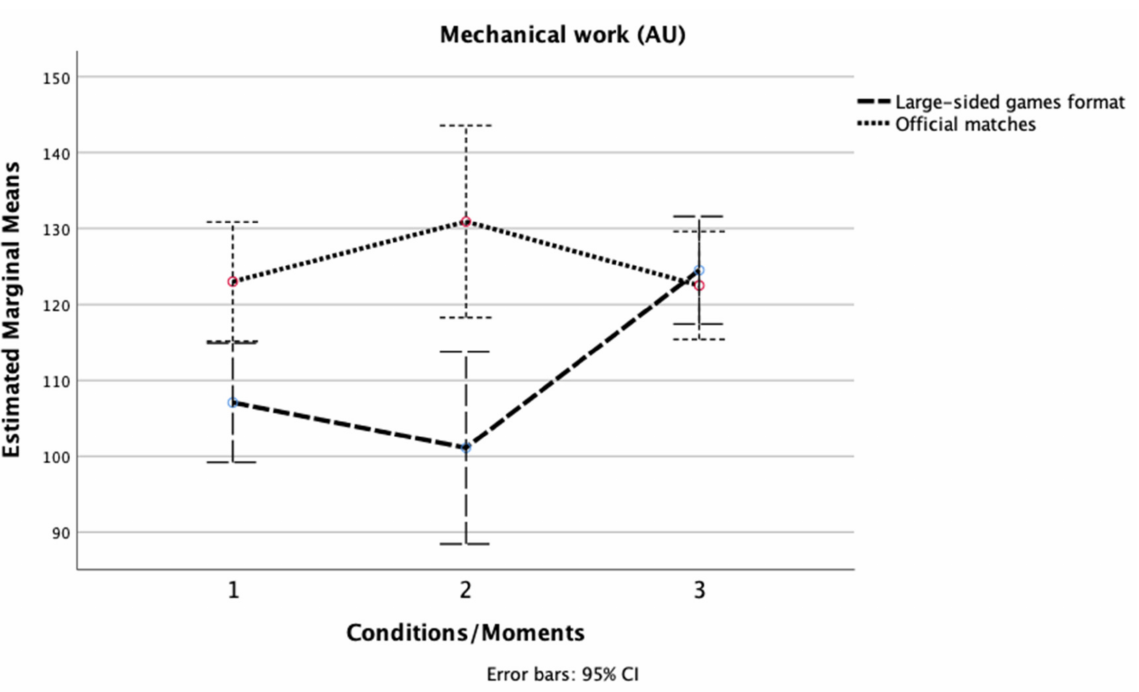
Figure 2. Changes in mechanical work across the three LSG formats and the three official